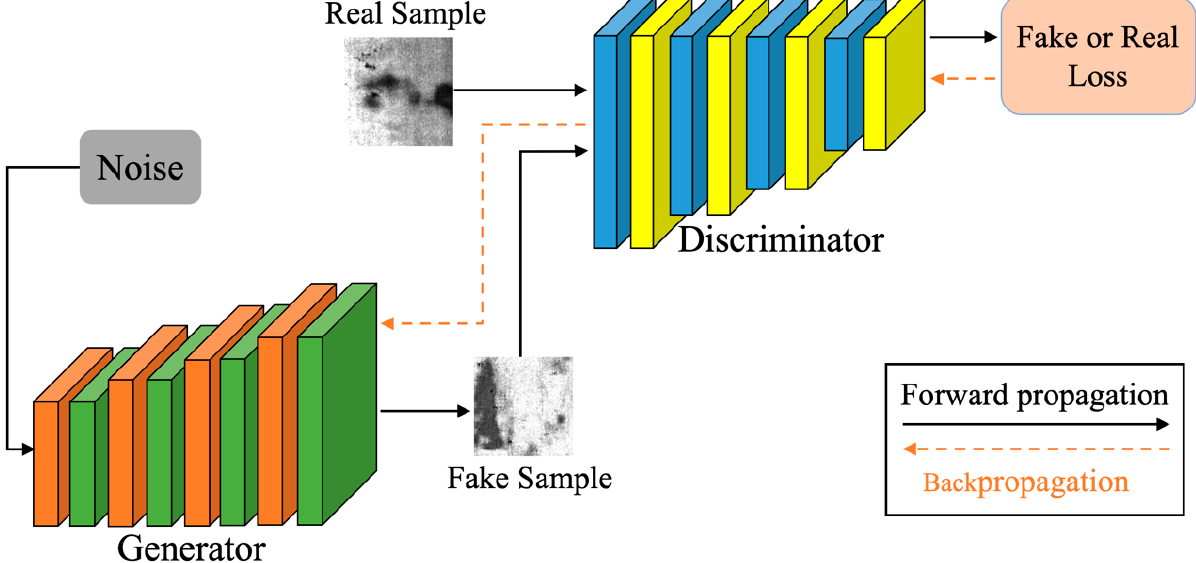
Figure 3. The structure of the